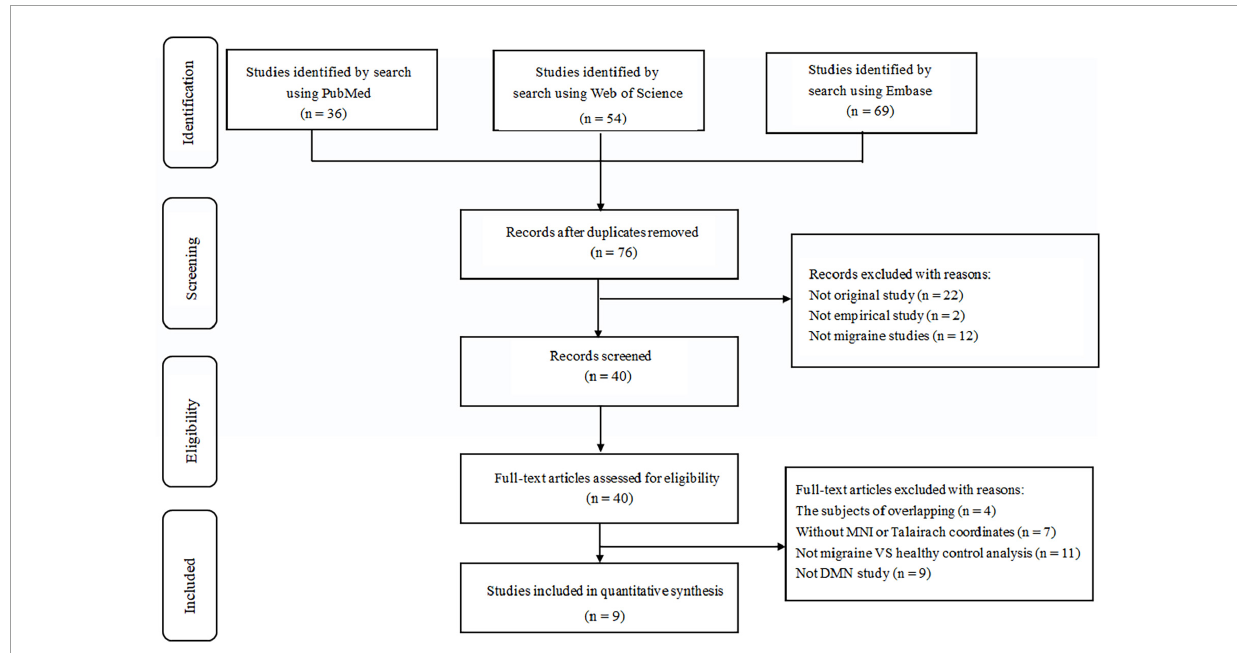
FIGURE1 Flow diagram for the identification and exclusion of studies. MNI, Montreal Neurological Institute; DMN, default mode network.